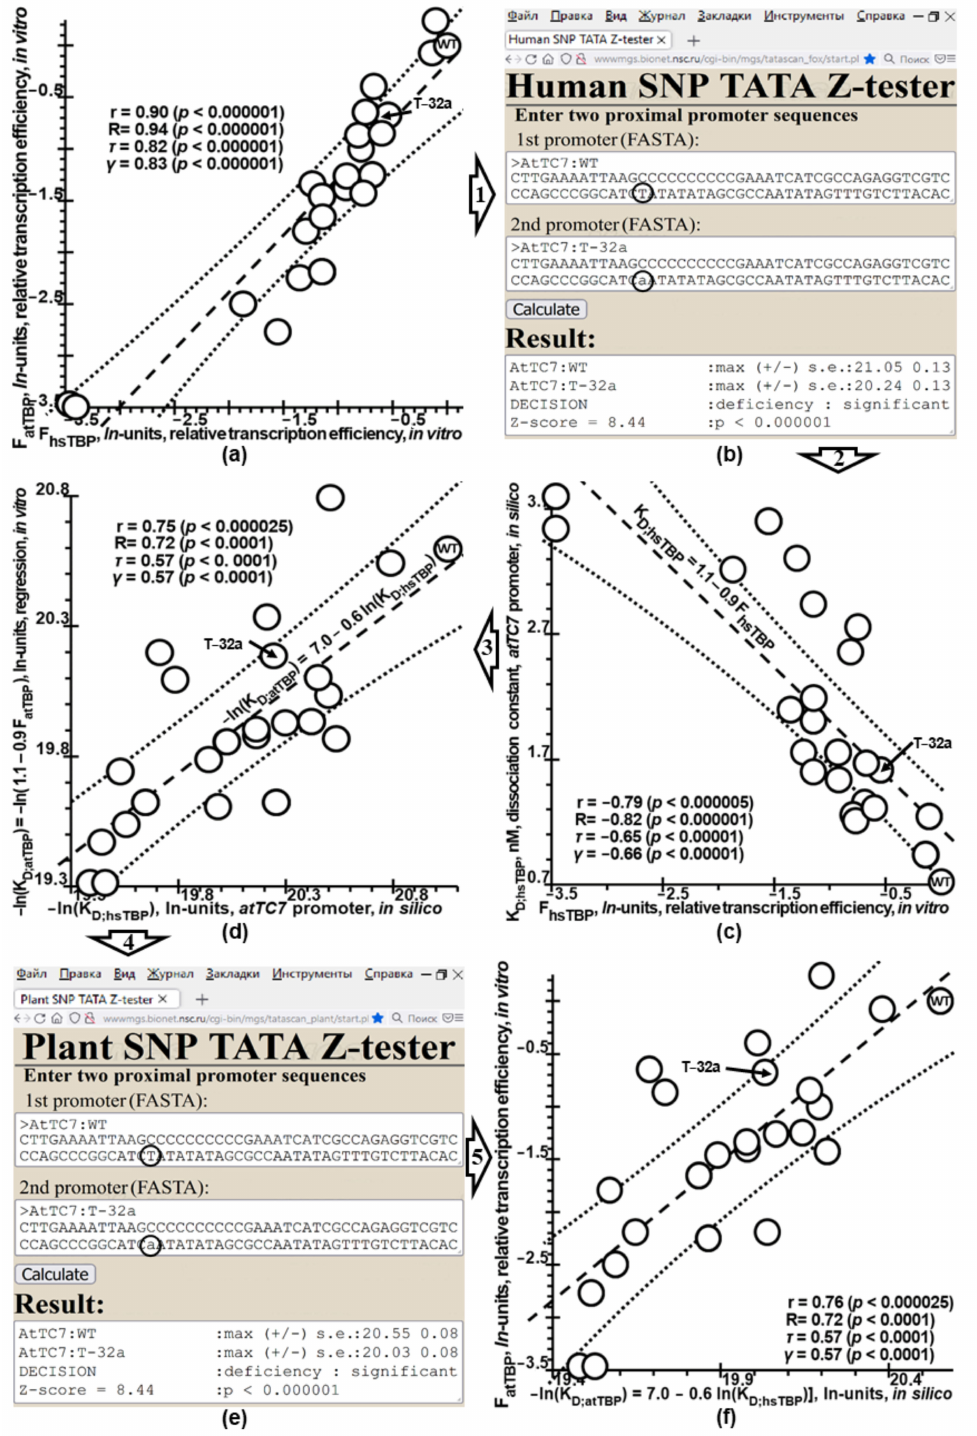
Figure 2. A stepwise flowchart of an empirical solution (found in this work) to the ill-posed inverse problem of how to uniformly estimate the effects of mutations in plant proximal promoters on gene expression. Legend : see the legend of Figure 1. ( a ) The interchangeability of hsTBP ( x -axis) and atTBP ( y -axis) for transcription in vitro [45]. ( b ) Using Human_SNP_TATA_Z-tester [28] (see in-depth description in the Supplementary Materials [18,28–33,35–39,41,42,62–67]), we estimated the − ln(K D; hsTBP ) values of hsTBP affinity for the 90 bp DNA sequence of either the wildtype or the mutant variant of the Agrobacterium tumefaciens T-DNA TC7 promoter ( AtTC7 ) [54] from [45], as